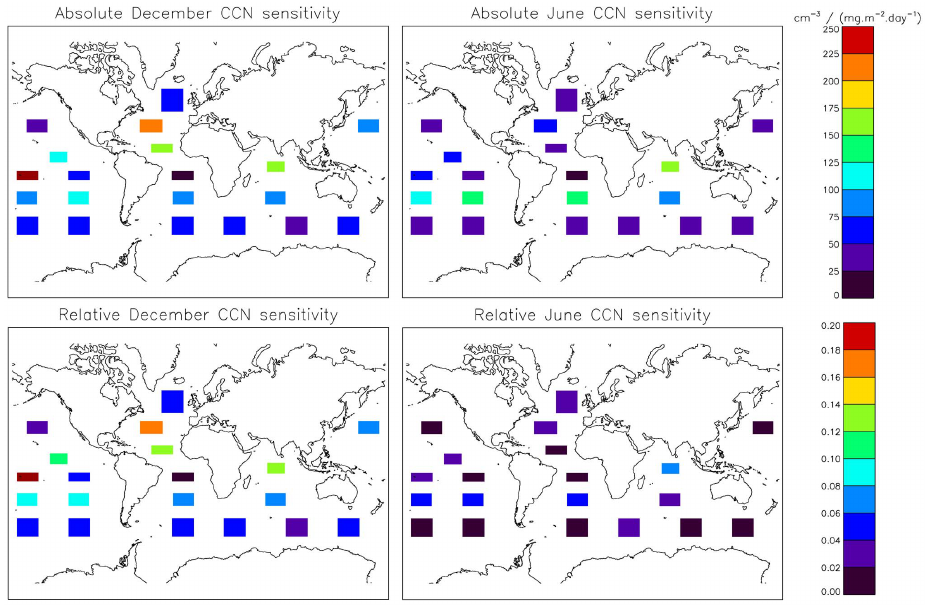
Fig. 4. Global mean absolute (top panels) and relative (bottom panels) CCN sensitivities for each patch for December (left) and June (right). The position of the shaded patches on the maps corresponds to the location of the perturbed patch in the experiment. The colour of the patch indicates the global mean sensitivity arising from that